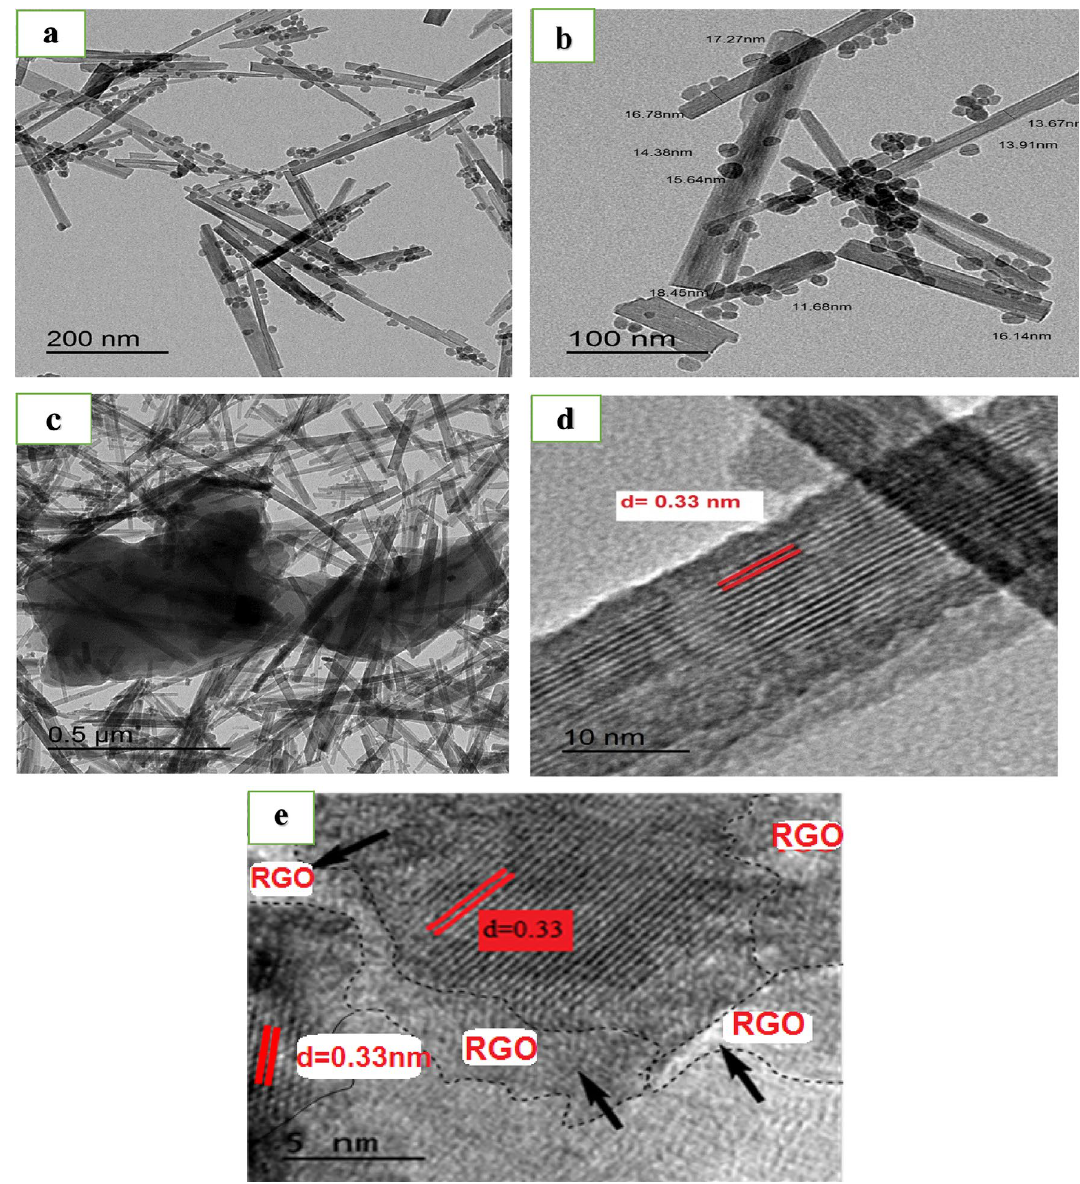
Figure 2. TEM and HR-TEM images of ( a , b , d ) Fe 3 O 4 –FeVO 4 and ( c , e ) 10%RGO/Fe 3 O 4 –FeVO 4